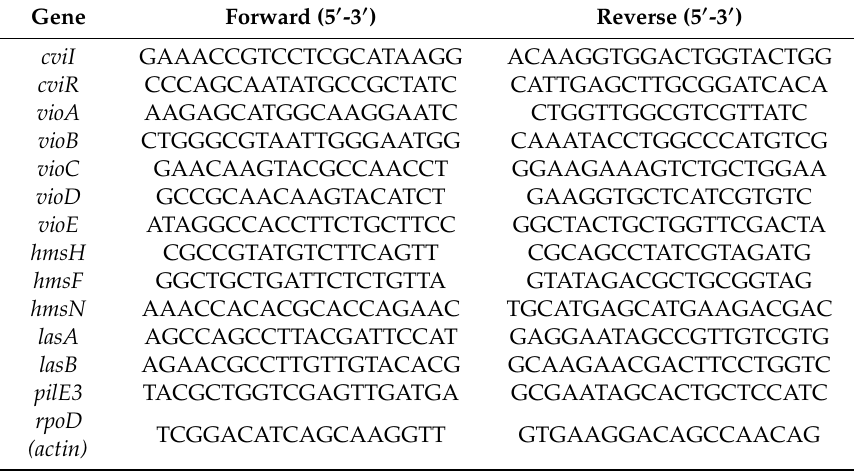
Table 3. PCR Primers for Fluorescence Real-Time Quantitative PCR.